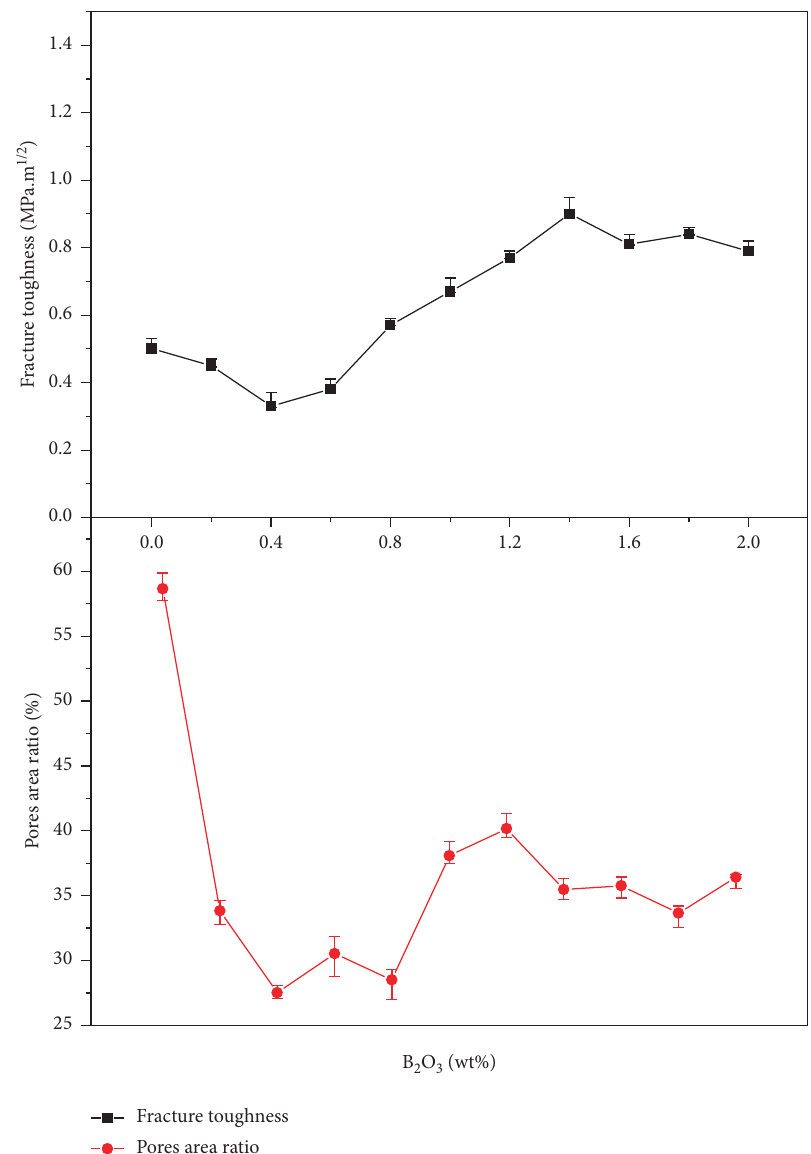
Figure 5: Pores area ratio and average fracture toughness of pellets with different B